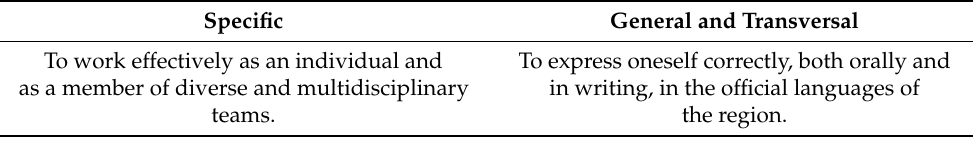
Table 1. Competences of the subject Fundamentals of